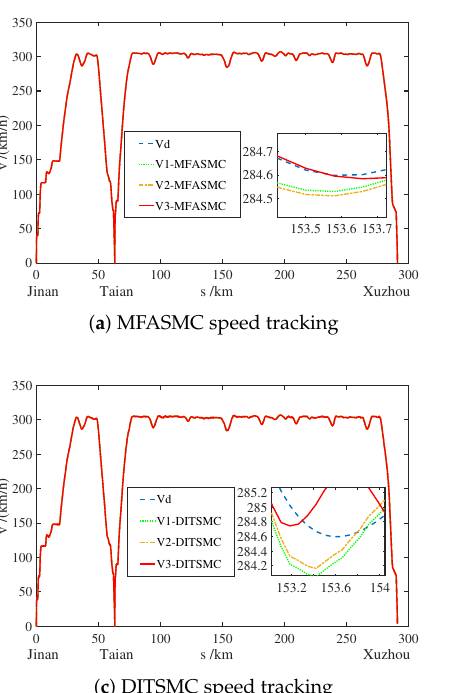
Figure 10. Speed tracking curves of each power unit for the three methods.